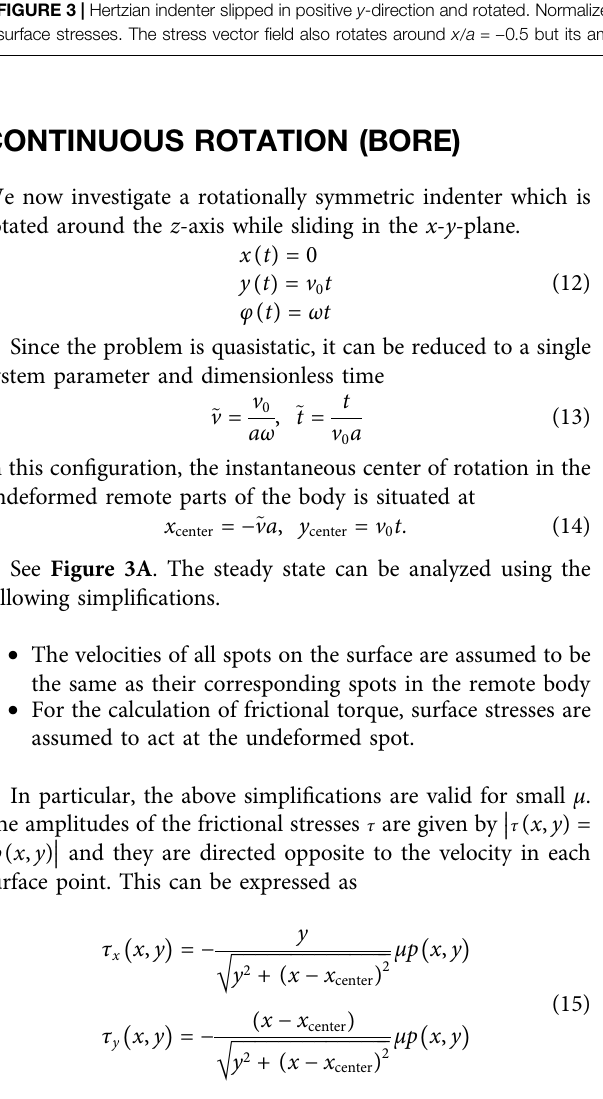
Frontiers in Mechanical Engineering |